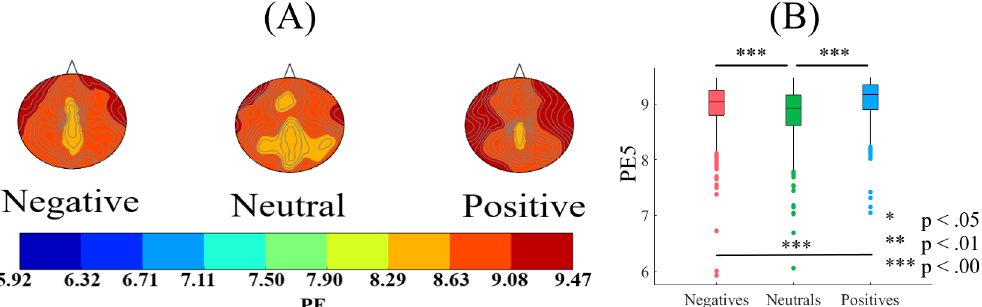
differences (yellow line) and their corresponding 95% confidence interval for positive vs. neutral (Figure A16A), positive vs. negative (Figure A16B), and negative vs. neutral (Figure A16C) are shown. The column “SD dif f ” in this table presents the standard deviation associated with each of these paired mean differences.